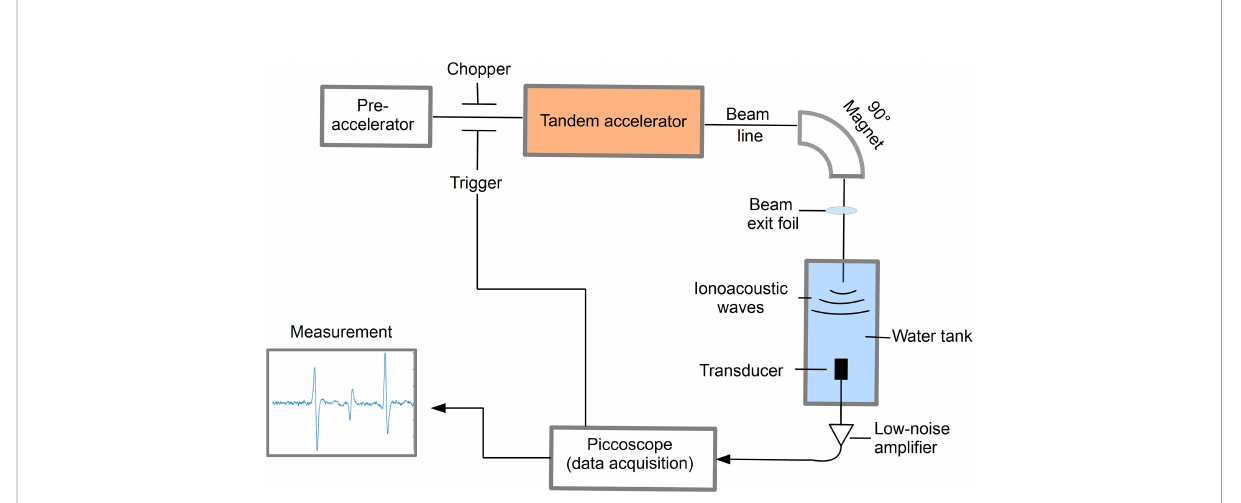
FIGURE 1 Schematic illustration of the experimental setup to detect ionoacoustic signals at a proton energy of 20